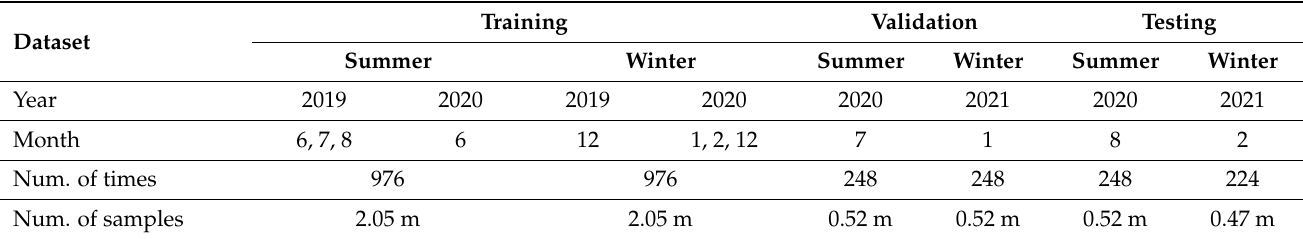
Table 2. Summary of data used in this study (“m” represents